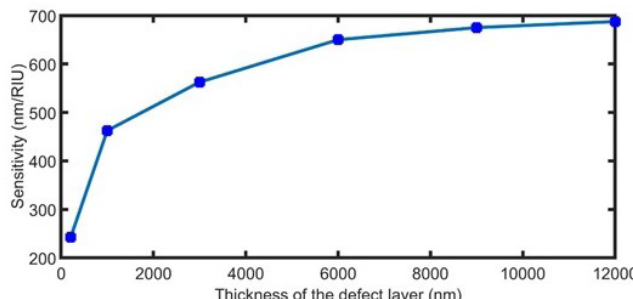
Figure 5. The effect of increasing the defect layer thickness on sensitivity at normal incidence.